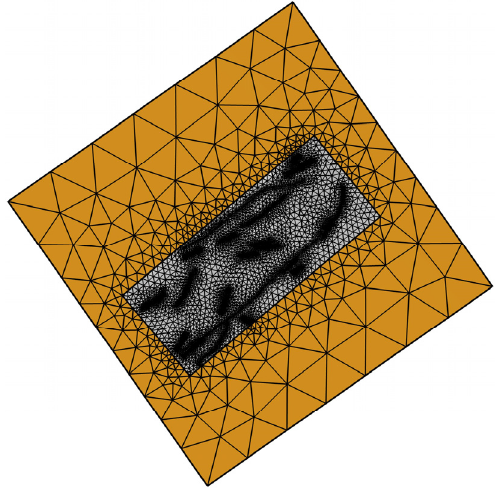
Figure 8. Finite element meshing